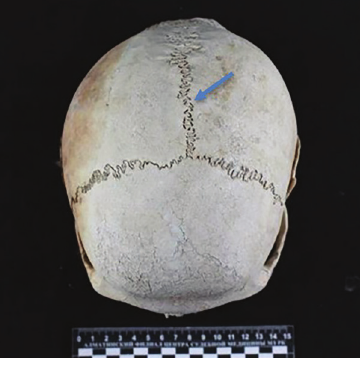
Figure 3 - Skull, top view (the arrow indicates the described changes)